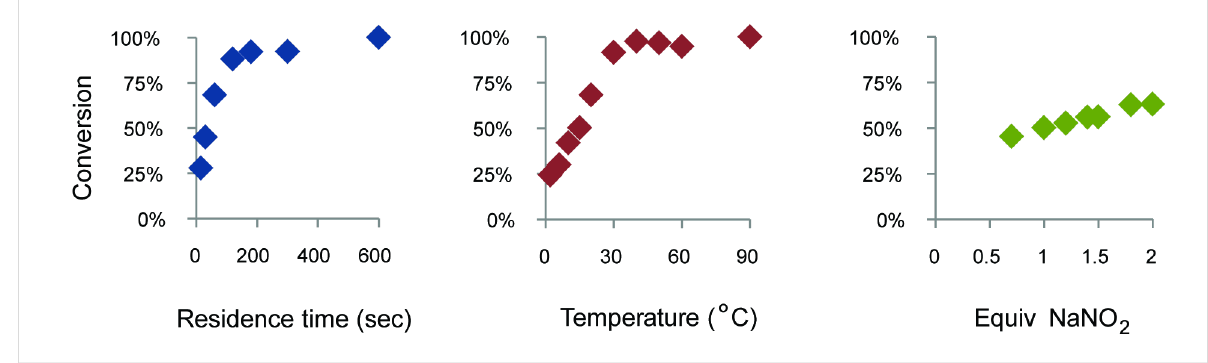
Figure 2: Univariate optimization using 30 s, 15 °C and 1.5 equiv NaNO 2 as standard.